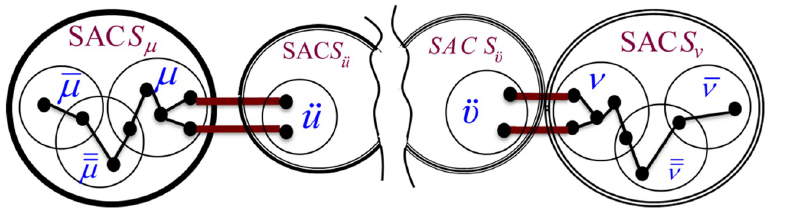
Fig 19. Generic notations used for constructing the formula in Eq 9 for computing the BI of an implicit Association Edge ( μ , ν ).